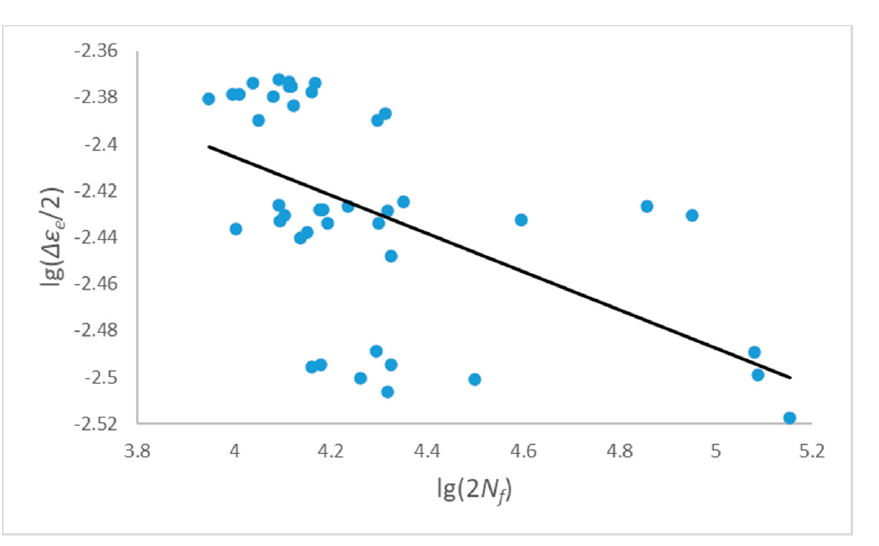
Figure 3. Fitting of elastic parameters when R = 0.2.